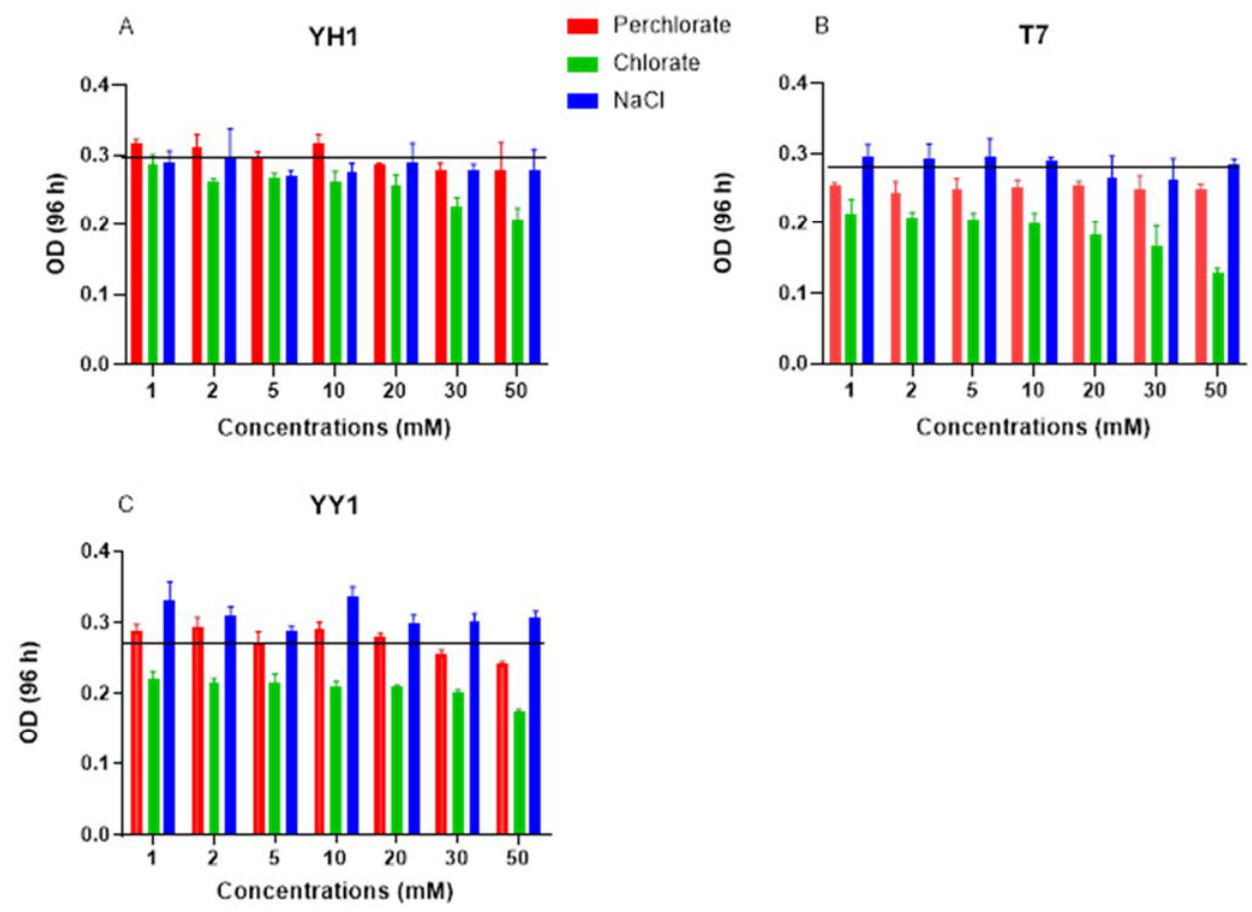
Figure 4. Biomass yield of the three RDX degrader strains at 96 h in the presence of increasing perchlorate, chlorate, and NaCl concentrations. Horizontal line represents the control yield. All cultures were initiated at an OD 600 of 0.05 at time zero with 20 mg/L RDX and 1 g/L glucose. ( A ) Strain YH1, ( B ) strain T7, and ( C ) strain YY1. Results are average ± standard deviation of triplicate cultures.